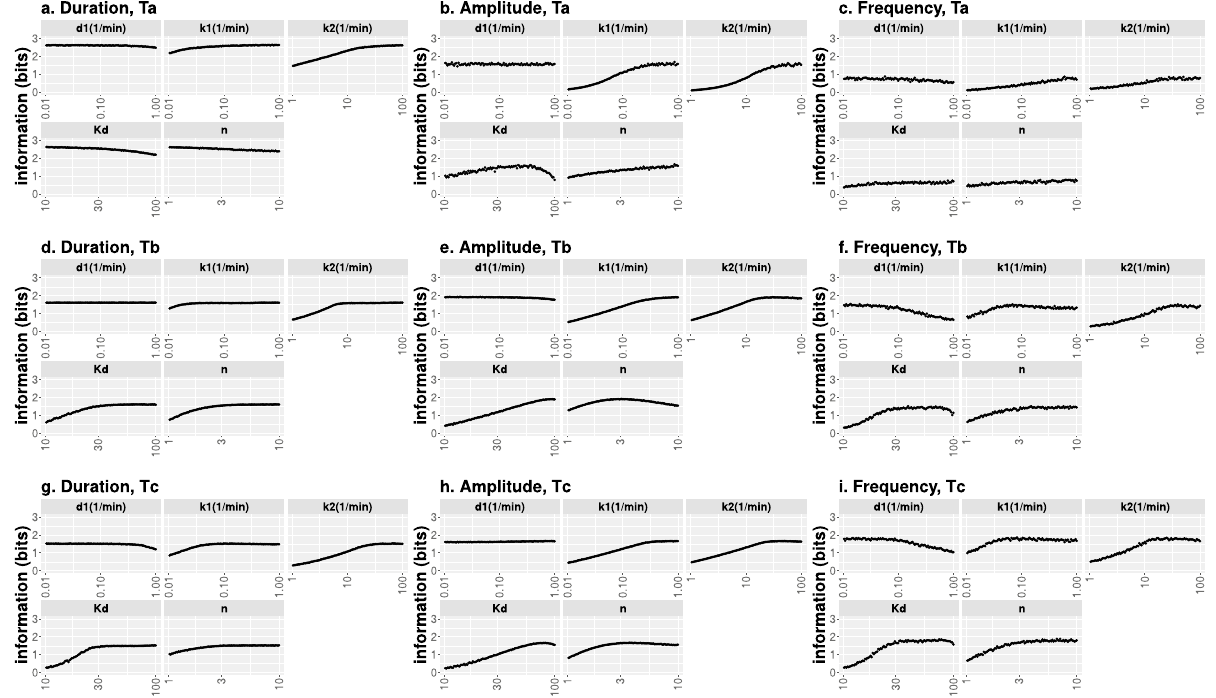
Figure 2. Behavior of mutual information, MI , around its maximum value, MI M , when one kinetic parameter is varied. We show MI as a function of the corresponding parameter for each type of input modulation and output time cut ( a – c , d – f , g – i correspond, respectively, to the T a , T b and T c output time cuts; a – d – g , b – e – h , c – f – i correspond, respectively, to duration, amplitude and frequency input modulation type). Except for the modulation by duration and the T a time cut, the rest of the behaviors are very similar across modulations and time cuts. In particular, the highest information is obtained if d 1 is low, k 1 , k 2 and n are high and K d is in a middle-high range, but not too high. For the T a time cut and duration modulation type K d and n need to be low to maximize MI